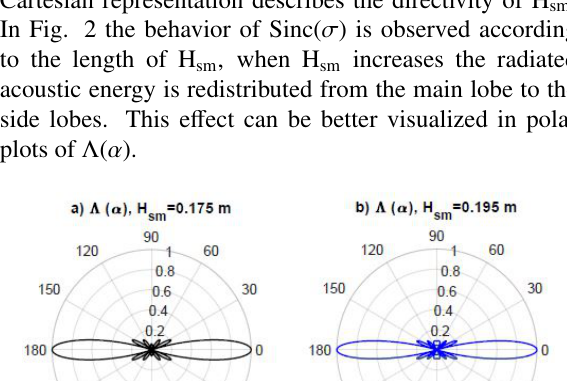
Figure 1. The silo as a continuous line source.